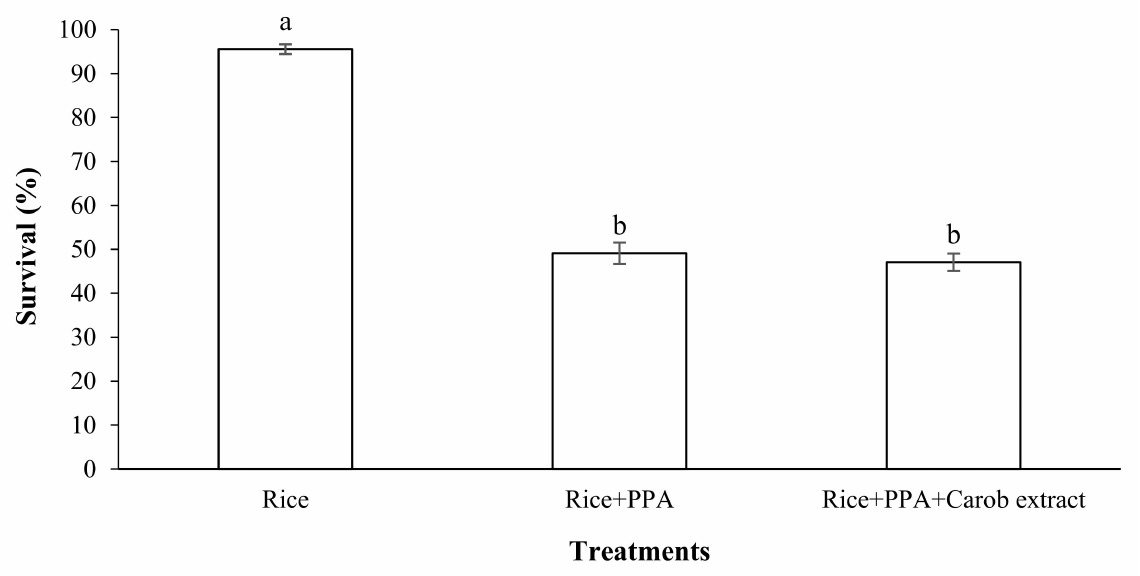
Figure 8. Effect of mixture of PPA and carob extract as food attractant on survival of Sitophilus oryzae adults (observation interval: 7 days). Means followed by different letters in each column are significantly different ( p < 0.05, Tukey’s